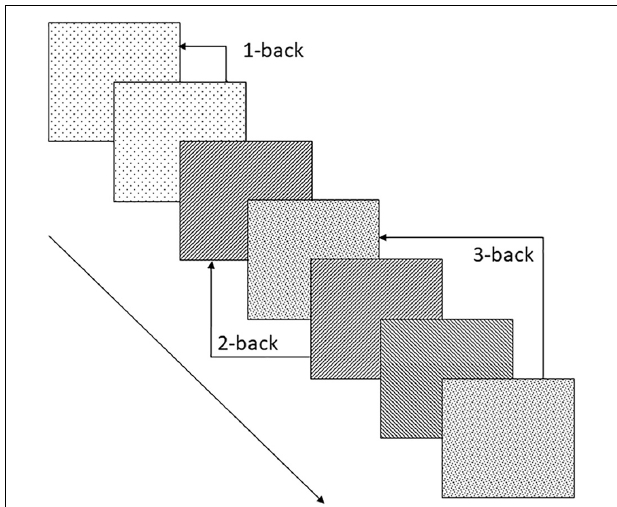
FIGURE 1 | Schematic representation of the n-back working memory task with examples of 1-, 2- and 3-back matches. Each square represents a visual stimulus that may be for example a video-recorded sign or a picture of an object. The pattern in each square represents a given characteristic of the stimulus which may be the stimulus as a whole, a surface feature of the stimulus such sign handshape (if the stimulus is a video-recorded sign) or an inferred feature of the stimulus such as the handshape of the sign gloss of a depicted object.